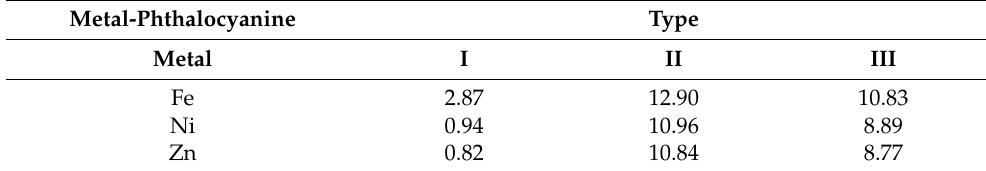
Table 8. Computed partition coefficient (logP).